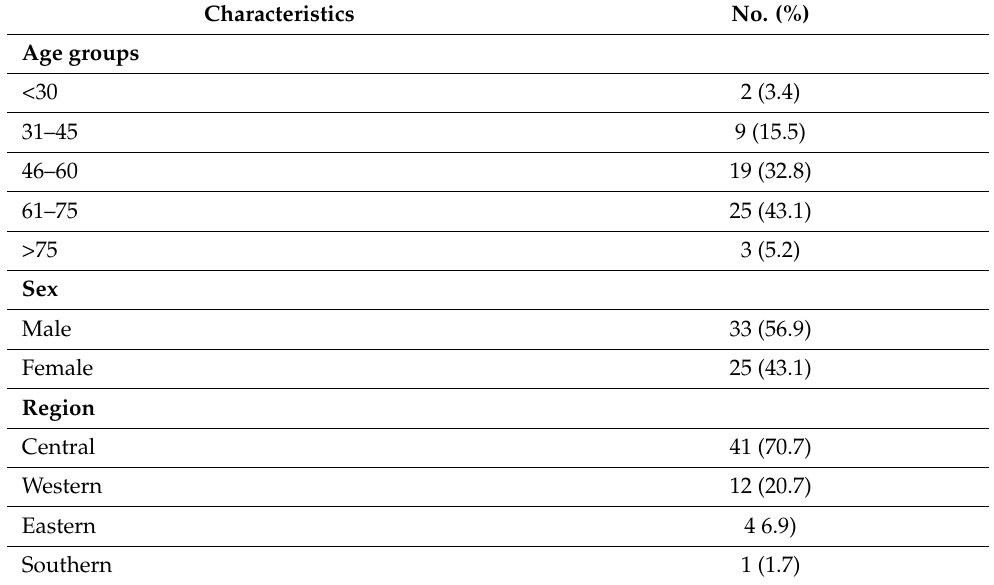
Table 1. Characteristics of study subjects ( n =